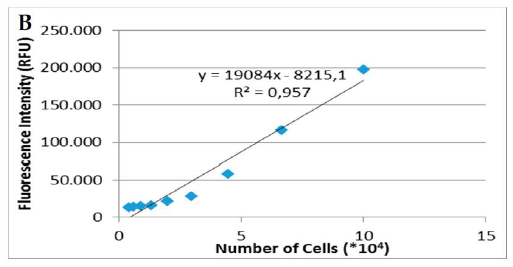
Figure A1. Calibration curves correlating fluorescence intensity to actual cell numbers: ( A ) osteoblasts; and ( B ) fibroblasts.